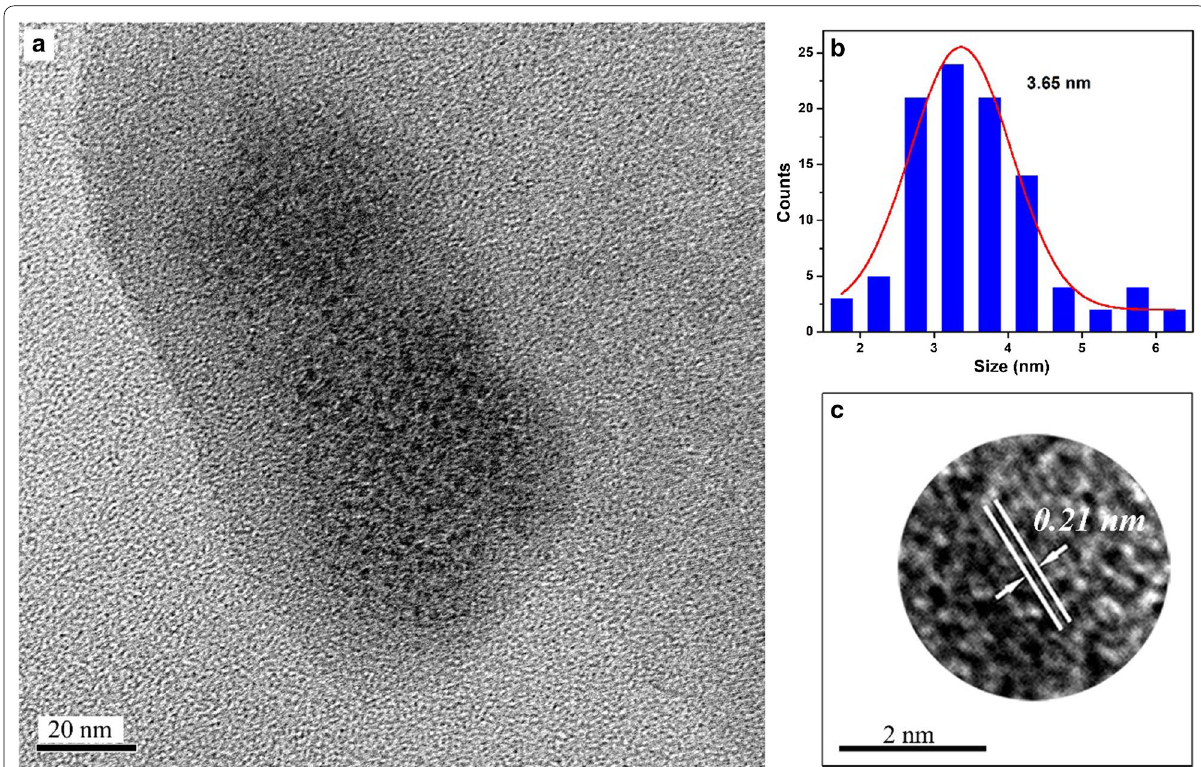
Fig. 3 a TEM images of A o -CDs, b the particle size distribution histograms, and c HR-TEM